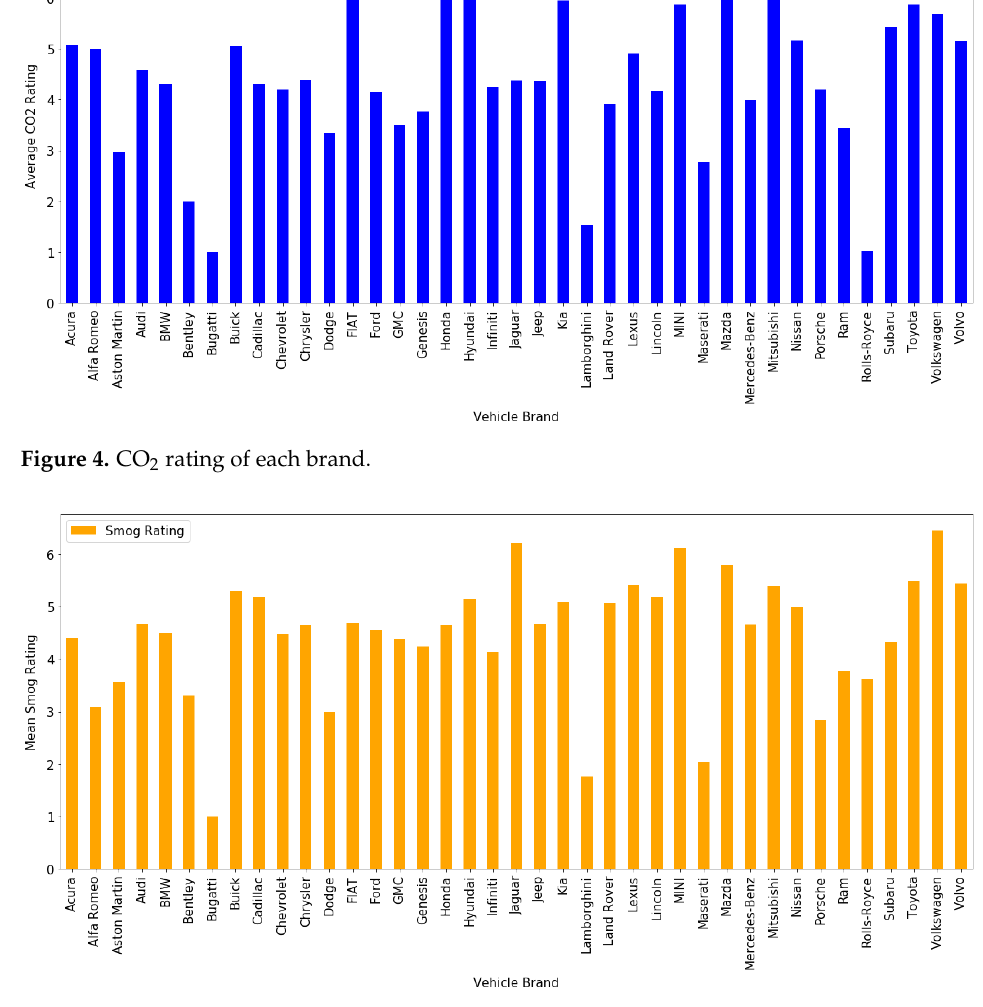
Figure 5. Smog rating of each